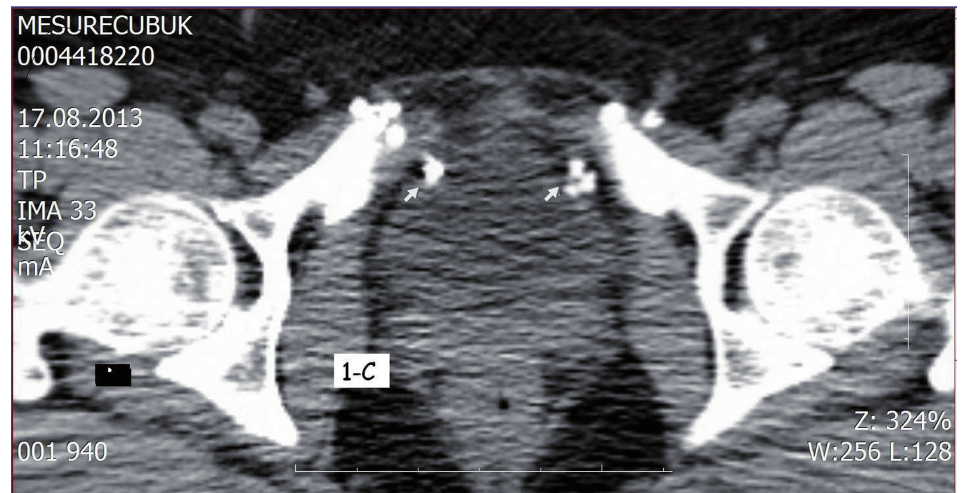
Figure 1c - CT image of normally localized